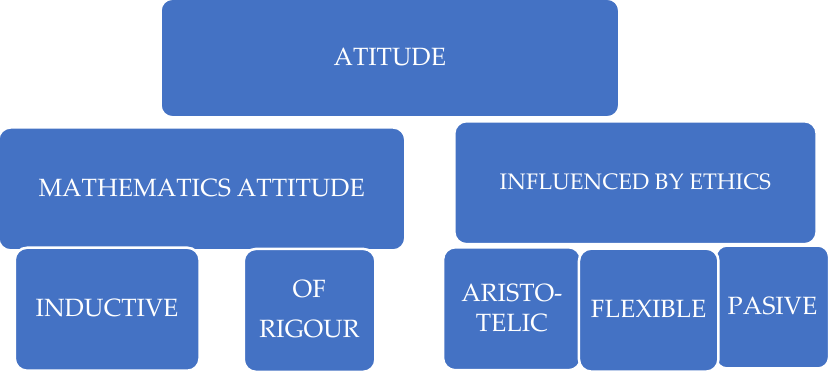
Figure 1. Attitude influenced by ethics and mathematics attitude; designed by the